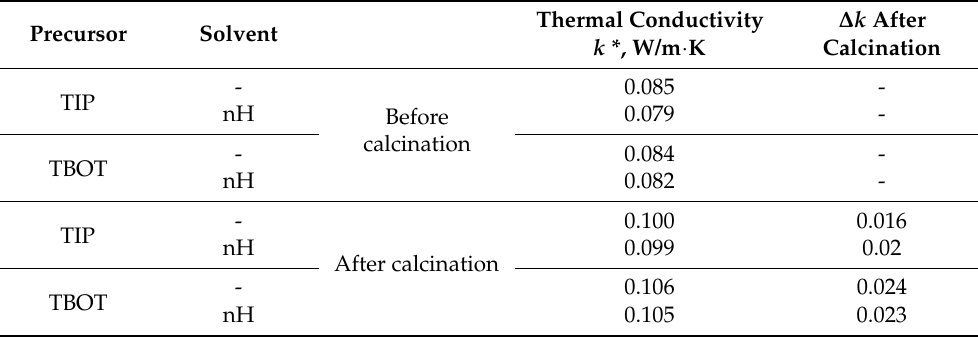
Table 5. Results of thermal conductivity measurements of the aged and calcinated TiO 2 aerogel samples.